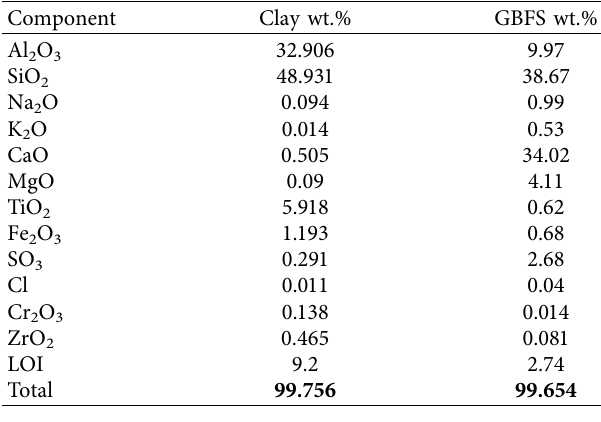
Table 1: Chemical analysis of raw materials.